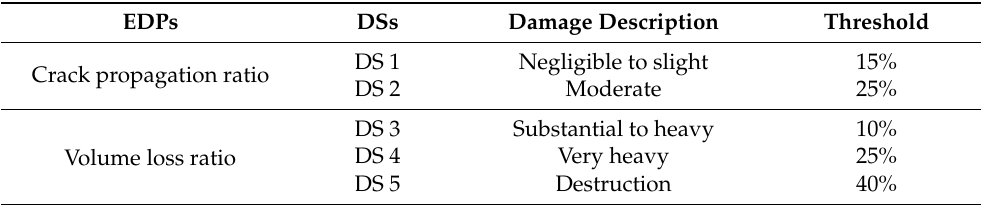
Table 4. EDPs and DSs and the corresponding damage thresholds.